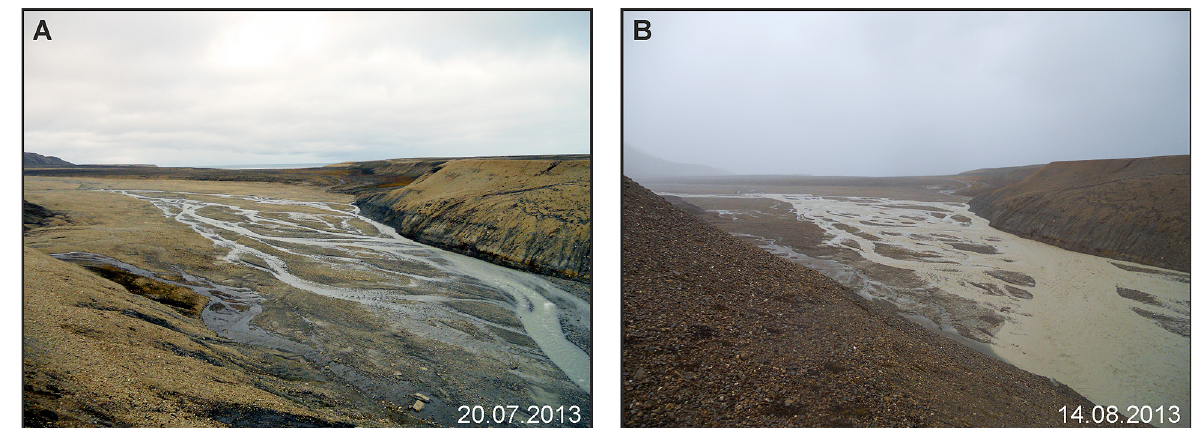
flooding.Fig. 5. Flooding in the gorge section of the Scott River in the research season 2013: A – before the flooding, B – during the